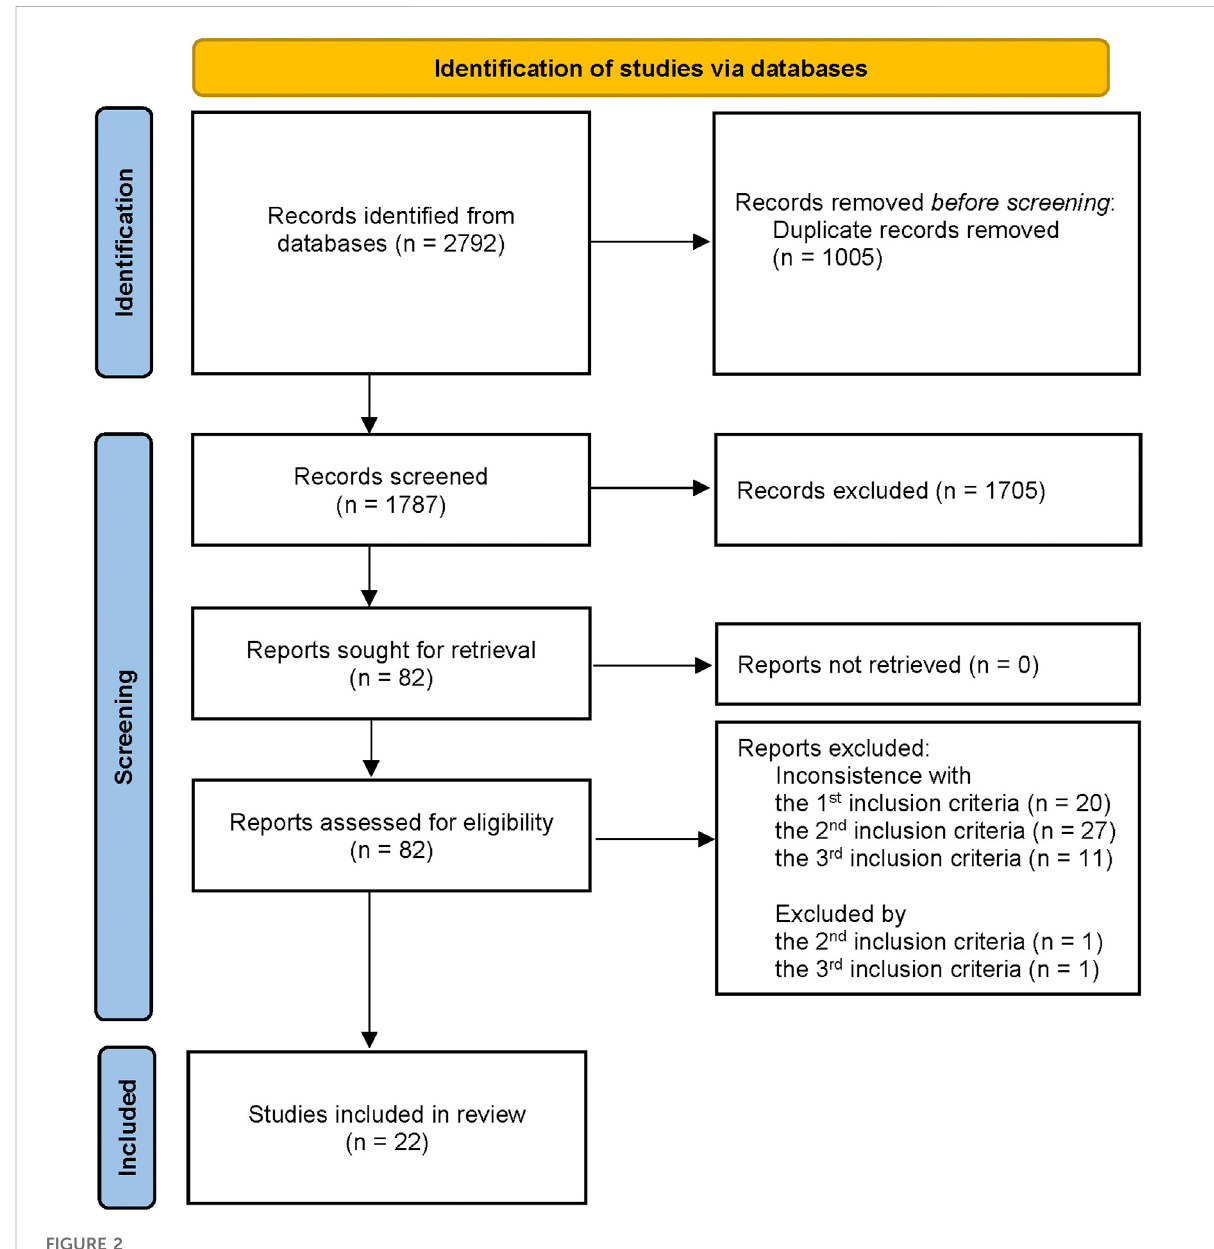
FIGURE 2 Flow chart of studies selected for the systematic